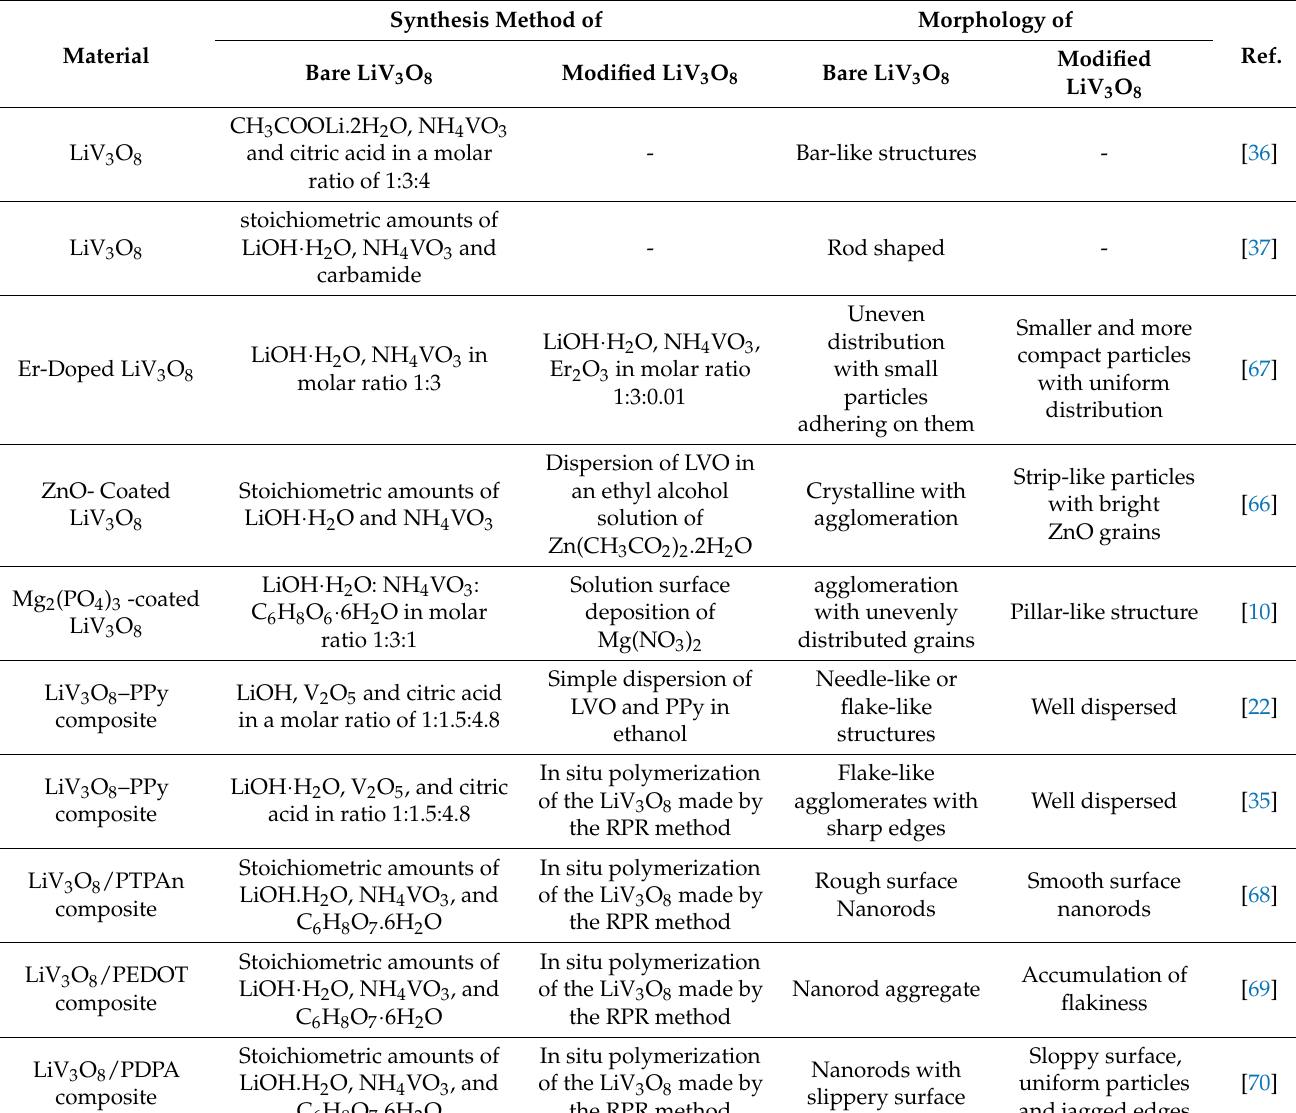
Table 1. Raw materials used and their corresponding morphology for bare and modified LiV 3 O 8